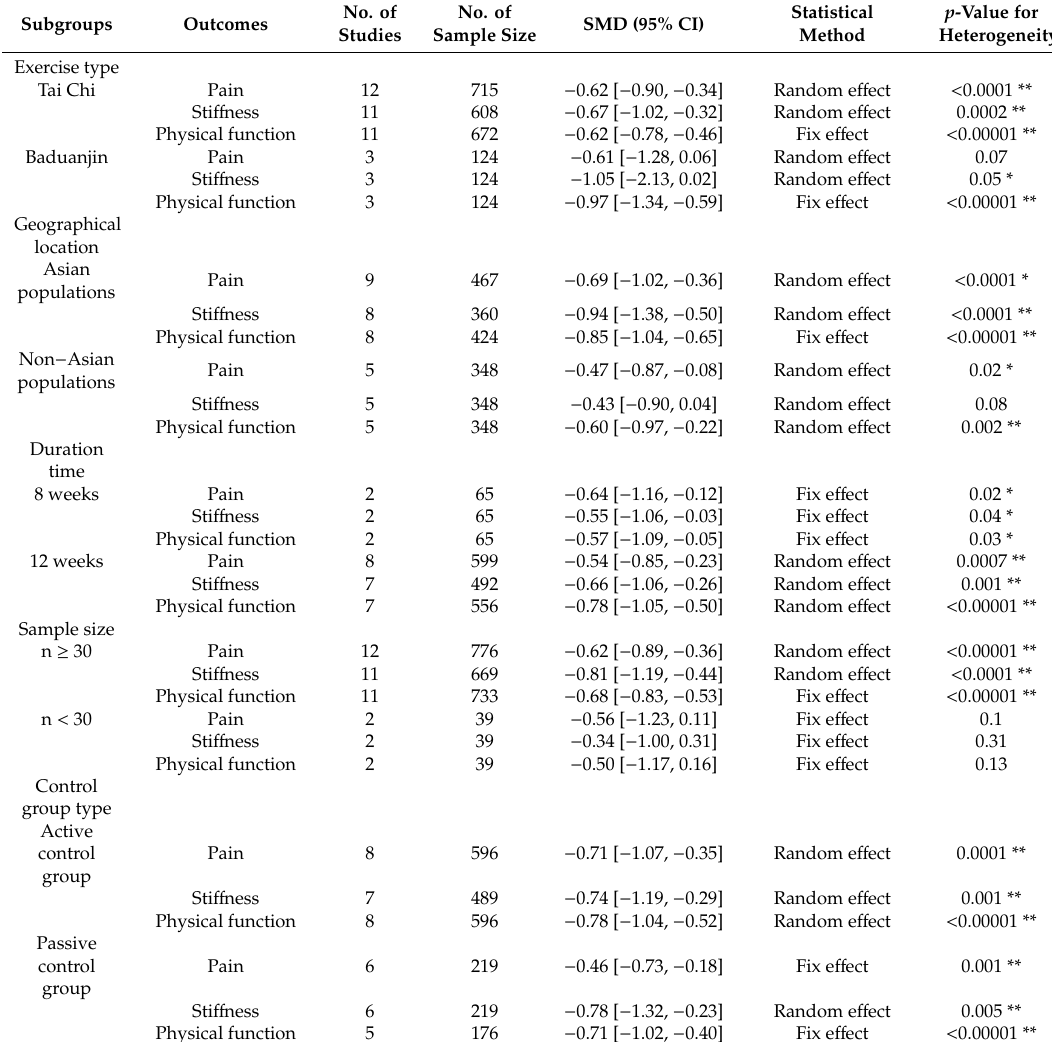
Table 2. Subgroup